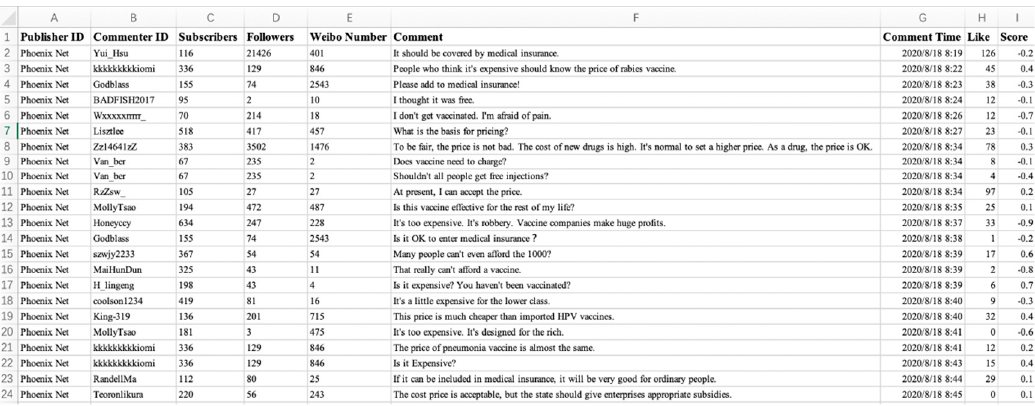
Figure 15. Crawl data form. Table 5. Comments information.